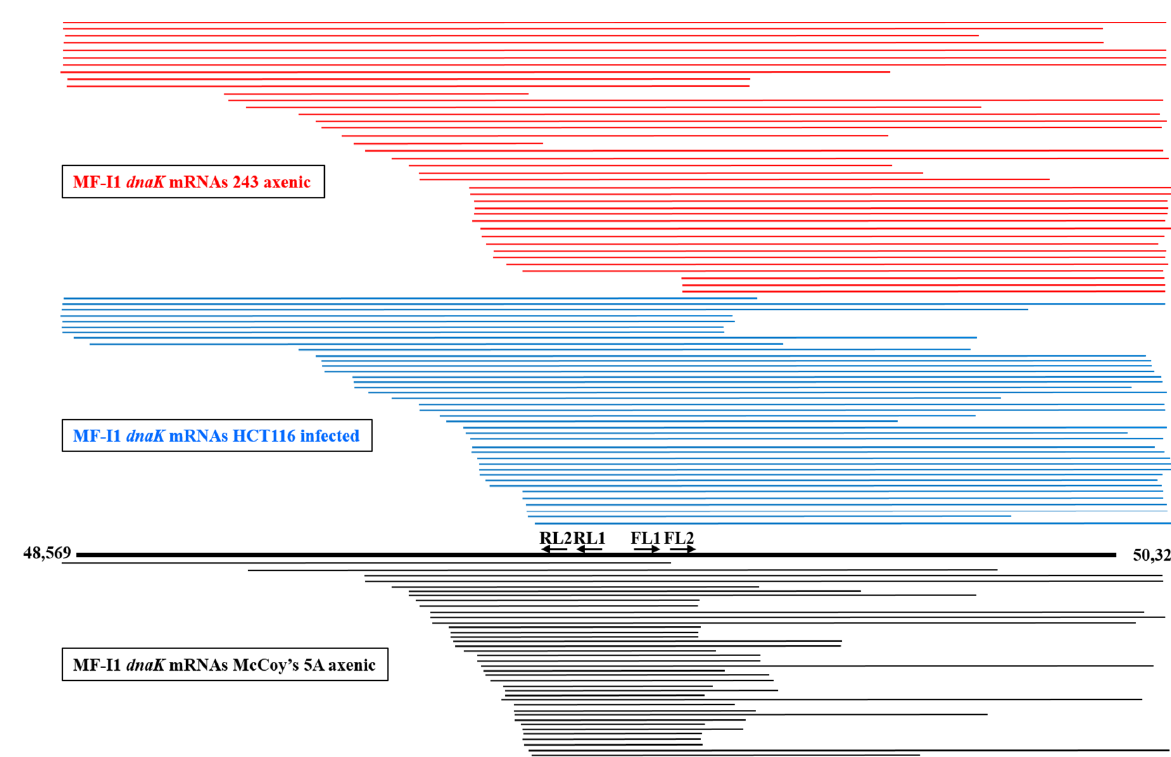
Figure 4. Schematic representation of dnaK RNA length obtained by cRT-PCR analysis. Mycoplasma dnaK mRNA lengths are indicated. The dnaK gene with the ATG start and TAA terminal codons is represented by the thick black line in the bottom. Primer pairs FL1/RL1 and FL2/RL2 used for cRT-PCR are also represented. Horizontal lines representing the cDNAs obtained by cRT-PCR technique are drawn to scale. The top lines in red represent the sequences derived from dnaK RNAs from the MF-I1 axenic culture in 243 medium, middle lines in blue represent sequences derived from dnaK RNAs from HCT116 cells infected with MF-I1, and the bottom lines in black represent the sequences derived from dnaK RNAs from the MF-I1 axenic culture in McCoy’s 5A medium. Numbers indicate the nucleotide position of the clone sequences, according to the sequence in GenBank accession (ATFG00000000) comprising the complete M. fermentans MF-I1 genome.